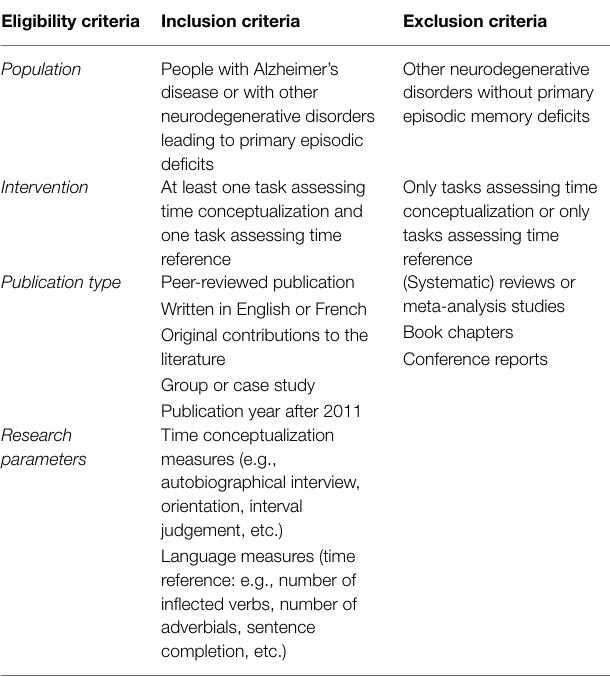
TABLE 2 | Overview of the eligibility criteria used for the selection of articles in the systematic